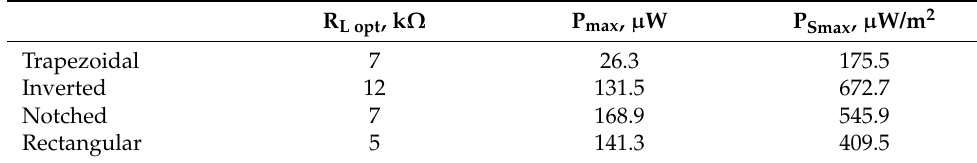
Table 2. Comparison of optimized PEH parameters [38].